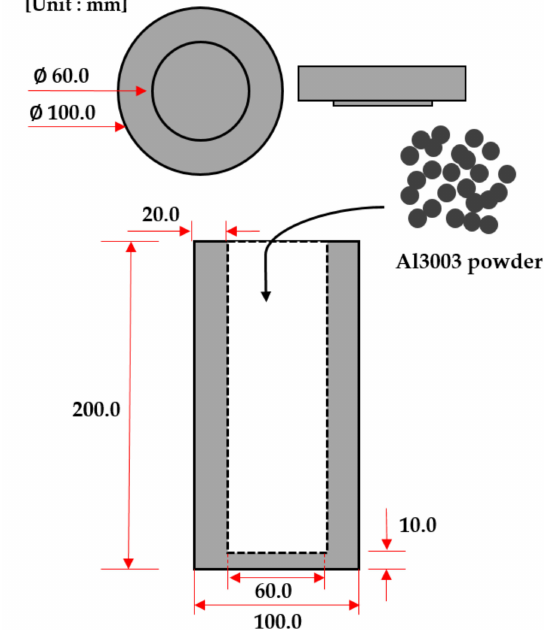
Figure 2. Schematic view of the Al6063 bulk cover and